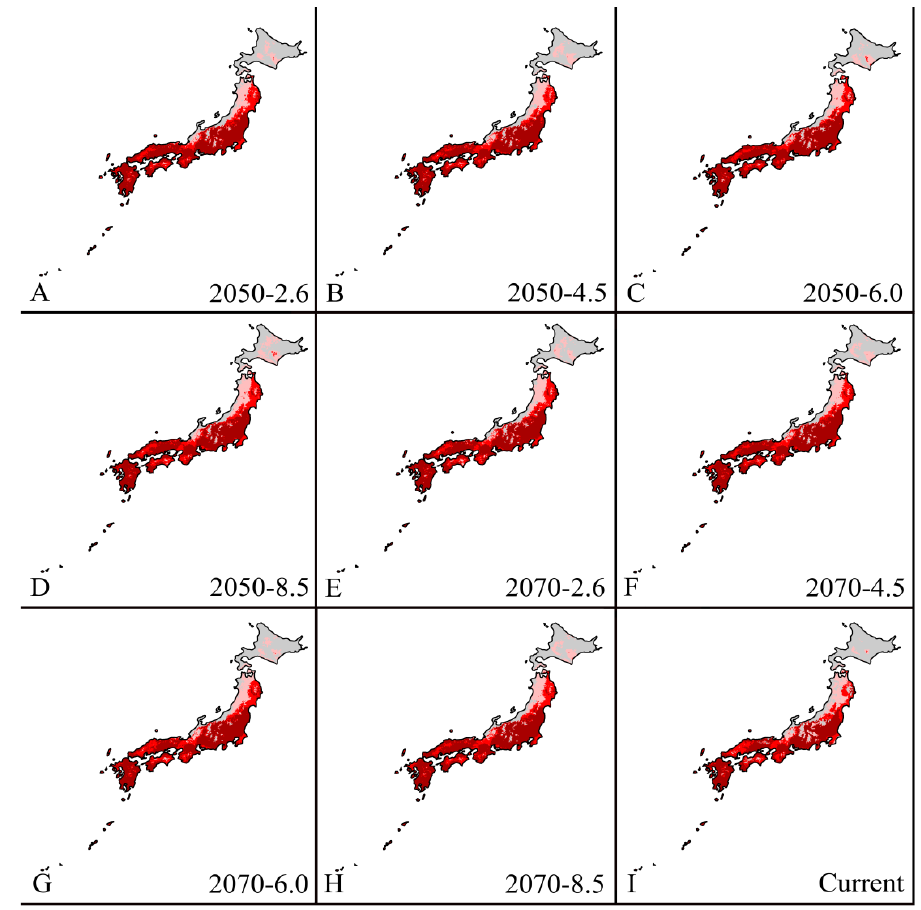
Figure 9. Future potential suitable habitats of Pseudaulacaspis pentagona on Japan continent under different climate scenarios predicated by MaxEnt. Pale red, unsuitable habitat area; Red, low habitat suitability area; Dark red, moderate habitat suitability area; Red, high habitat suitability area. ( A ) RCP 2050-2.6; ( B ) RCP 2050-4.5; ( C ) RCP 2050-6.0; ( D ) RCP 2050-8.5; ( E ) RCP 2070-2.6; ( F ) RCP 2070-4.5; ( G ) RCP 2070-6.0; ( H ) RCP 2070-8.5; ( I ) Current.